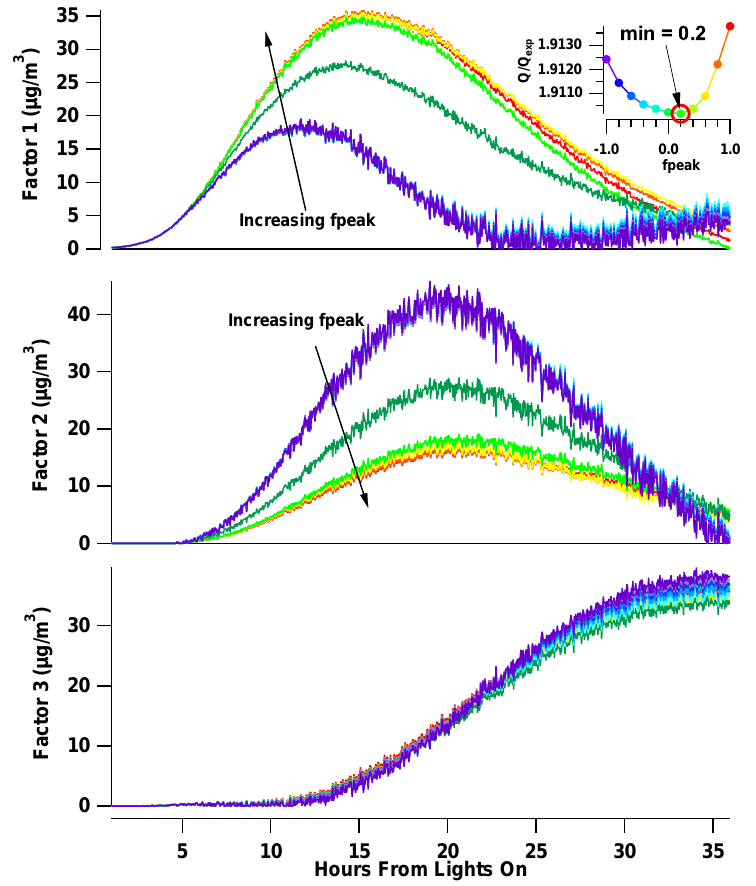
Fig. A7. The change in f peak affects factors 1 and 2 more than factor 3. The increase in factor 1 explains the decrease in factor 2 when f peak changes from 0 to 1. The same effect occurs when the f peak changes from 0 to − 1. There is a small change in factor 3, but overall trend and magnitude remain the same for factor 3. The minimum in Q is associated with an f peak of